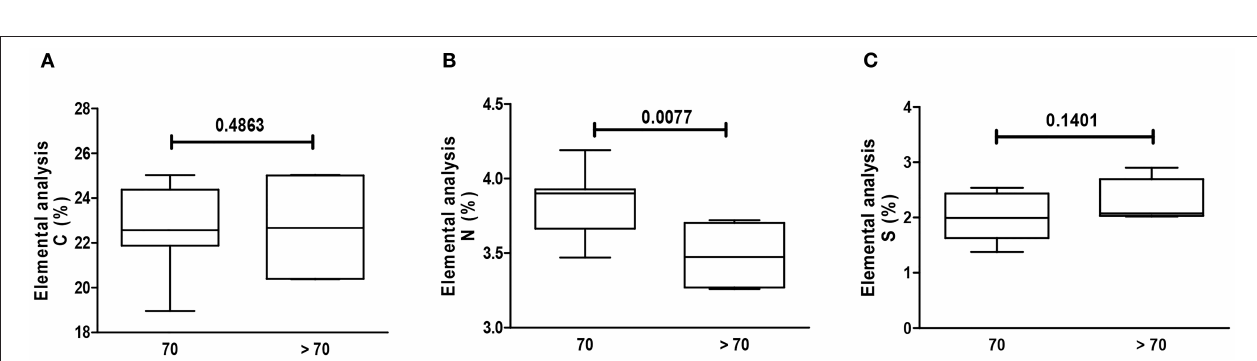
FIGURE 1 | Assessment of glycosaminoglycan (GAG) content. Human cartilage samples from patients subjected to arthroplasty secondary to OA or fracture were assessed for GAG content. Data represent mean ± SEM of GAG content ( µ g/mg) of dried cartilage as follows: patients > / ≤ 70 years old (A) , gender (B) , and OA and fracture (C) of at least n = 6/group; Student t -test.